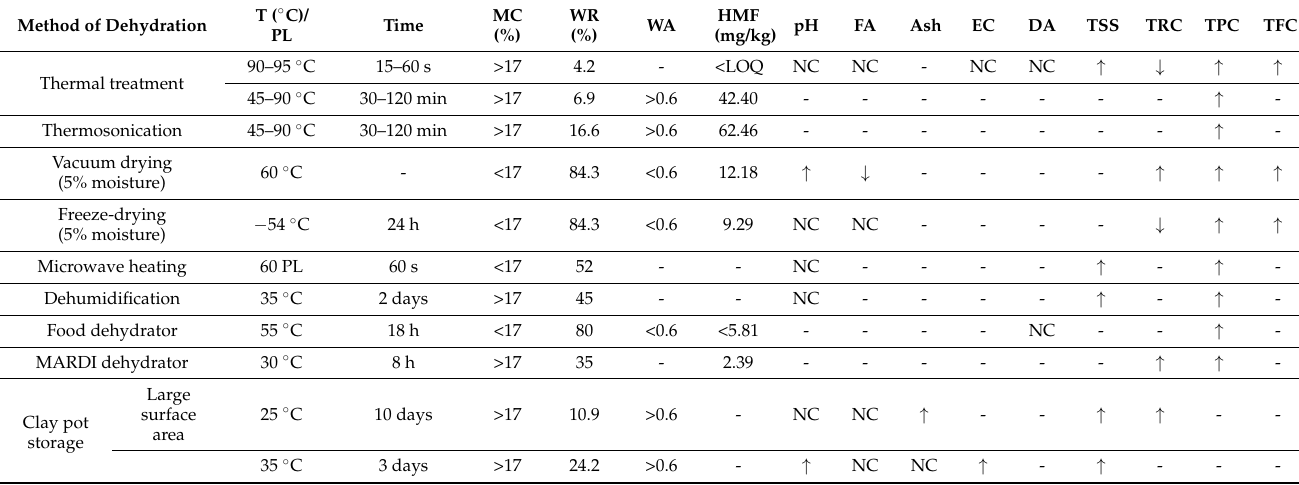
Table 15. The optimal setting for each dehydration methods and impact on physicochemical proper- ties of Stingless bee honey